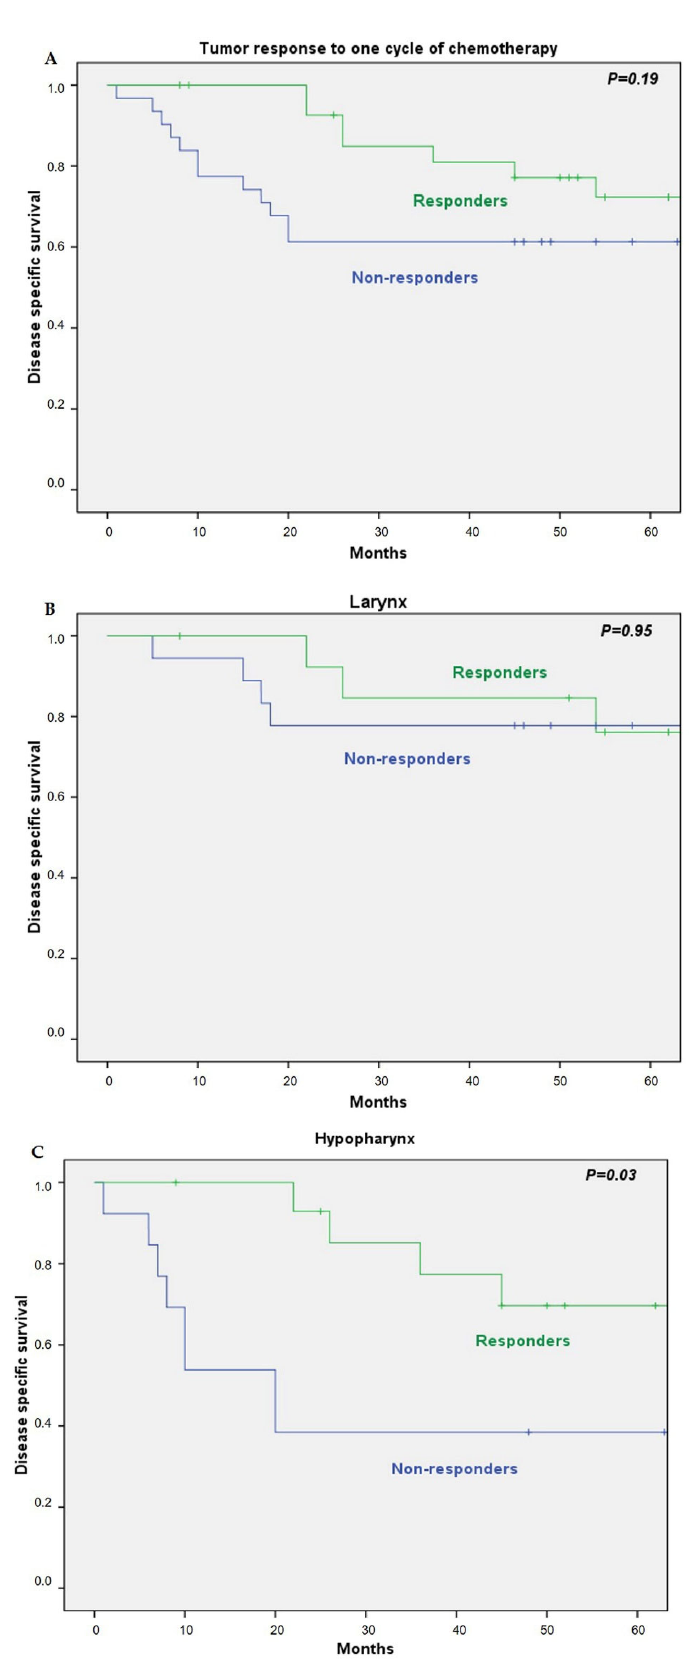
Figure 4. Disease-specific survival dependent on the response after one cycle of chemotherapy: Figure 4. Disease ‐ specific survival dependent on the response after one cycle of chemotherapy: ( A ) ( A ) all patients; ( B ) tumor location in larynx; ( C ) tumor location in the all patients; ( B ) tumor location in larynx; ( C ) tumor location in the hypopharynx. Similar to the OS and DSS, there were no significant differences between the ICT group and the up ‐ front surgery group for local control rate (HR 0.63; 95% CI 0.22–1.77; P